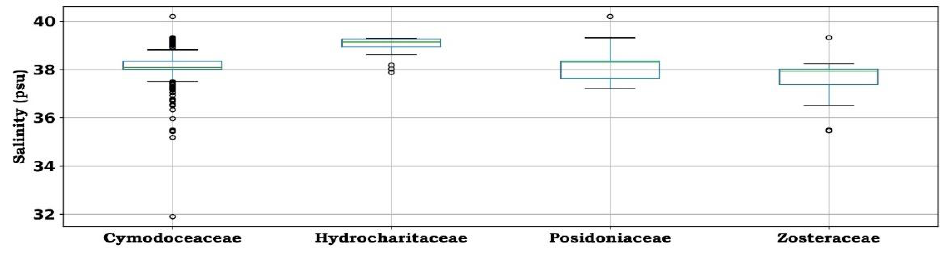
Figure 7. Box-Whisker plots of annual water salinity [psu] at the locations in which seagrass families are present in the Mediterranean Sea (inner line represents sample median, box boundaries represent the distance between the first and third quartile, error bars represent the 95% CI for the median, and open circles represent the outliers).